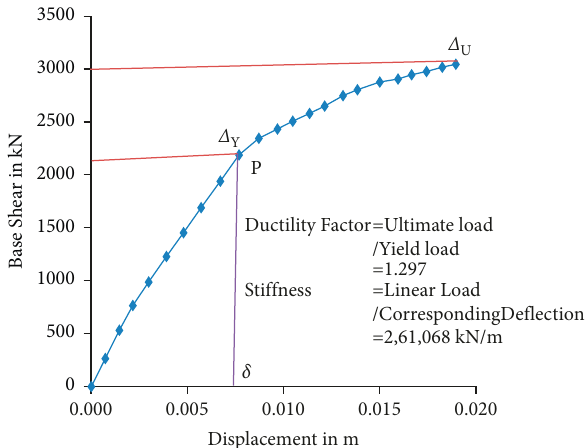
Figure 7: Infill frame in the Y